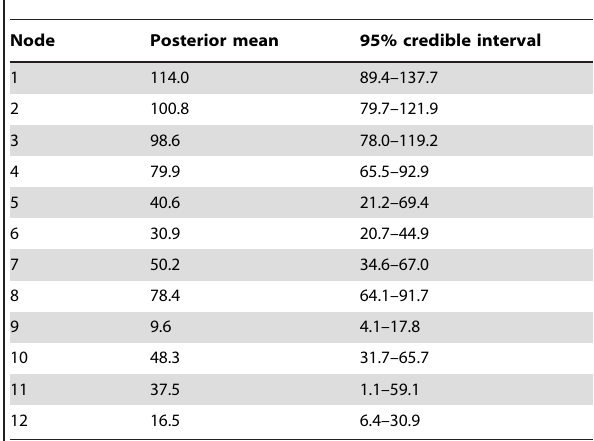
Table 2. Posterior means and 95% credible intervals of divergence time estimates (MA) of 12 nodes of the tree shown in Figure 4, based on the relaxed molecular-clock analysis for the 12 n RT n